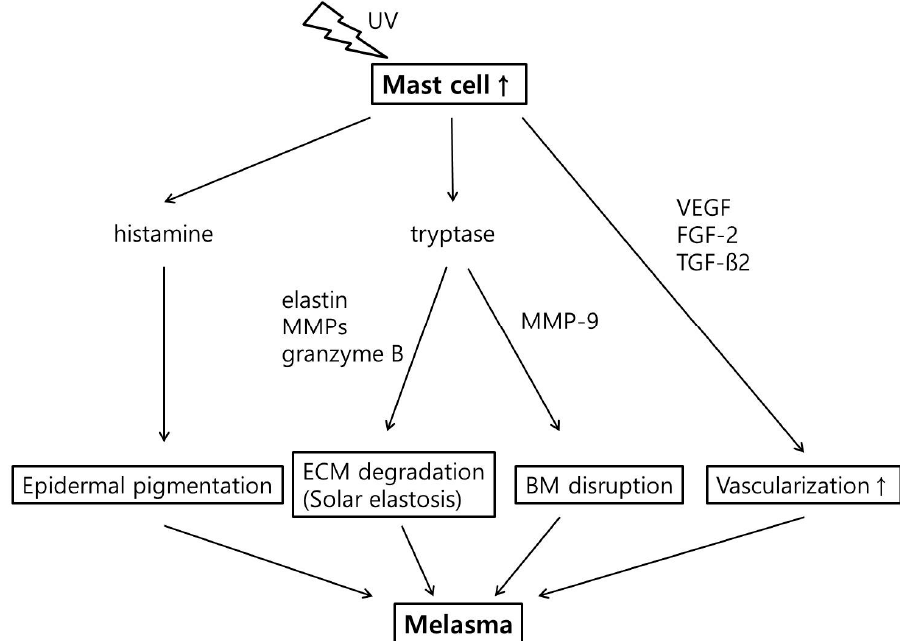
Figure 1. The role of mast cells in melanogenesis and photoaging. UV= ultraviolet; MMPs = matrix metalloproteases; VEGF = vascular endothelial growth factor; FGF-2 = fibroblast growth factor-2; TGF- β = transforming growth factor- β ; ECM = extracellular matrix; BM = basement membrane.